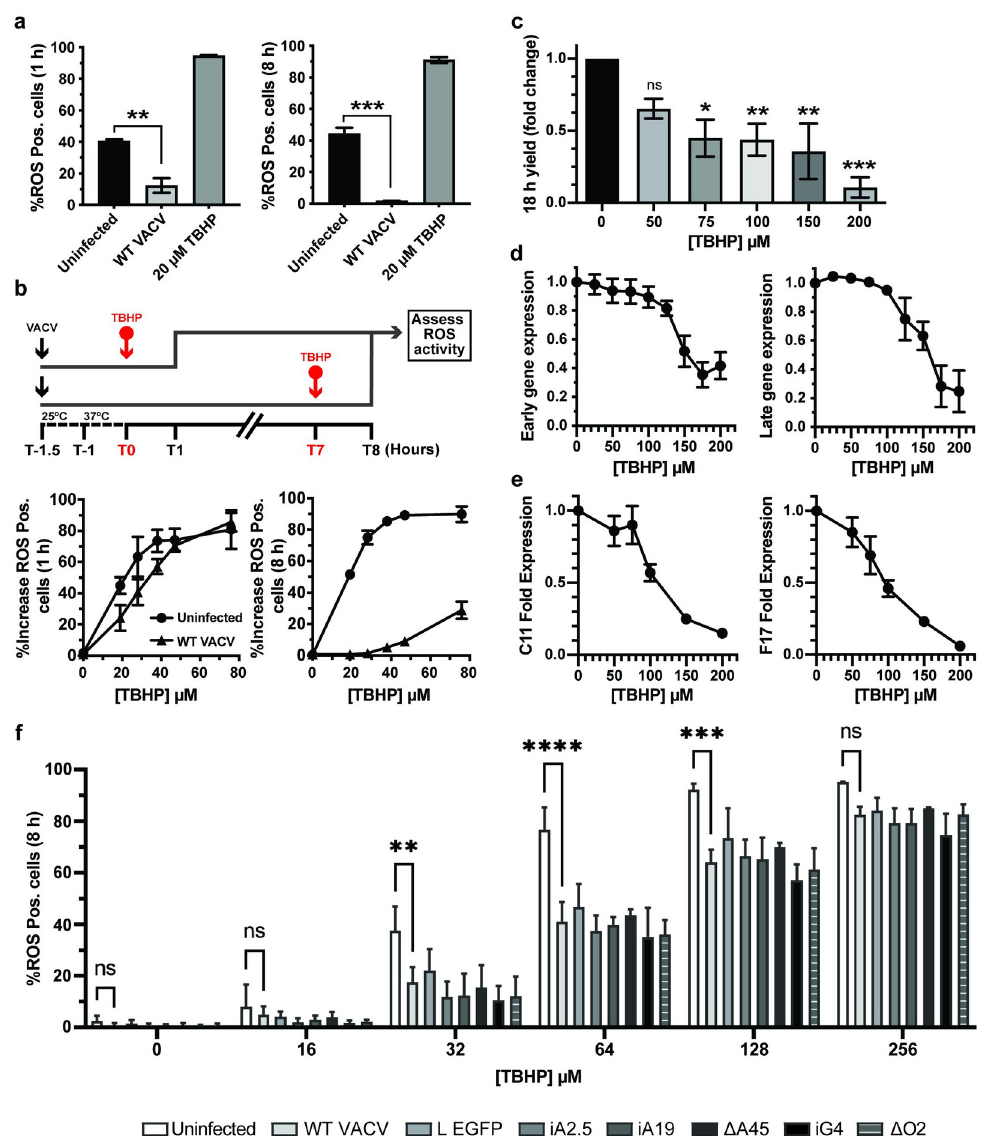
Fig 4. VACV supresses host cell oxidative responses to promote infection. (a) The percentage of ROS activated A549 cells measured at 1 and 8 h pi in cells left uninfected (black bar) or infected with WT VACV (Light grey bar). As a positive control, uninfected cells were treated with 20 μ M TBHP for the final hour of the experiment (dark grey bars). (b) Top: schematic of experiment to assess impact of VACV infection on ROS activation. VACV was bound to A549 cells for 30 min at RT prior to being shifted to 37˚C for 1 h. Cells were challenged with the indicated concentrations of ROS inducer TBHP for 1 h prior to quantification of ROS-positive cells at 1 h pi and 8 h pi. Bottom: The percentage of uninfected (circles) and infected (triangles) ROS positive cells at 1 h pi and 8 h pi challenged for the final hour with the indicated concentrations of TBHP (n = 3; ± SEM). (c) A549 cells were infected with WT WR VACV (MOI = 1) in a range of TBHP concentrations. At 18 h pi, the infectious virus yield was assessed by plaque assay (n = 3; mean ± SEM). (d) A549 cells infected with WR E-EGFP or L-EGFP were challenged with the indicated concentrations of TBHP for 8 h. Early and late viral gene expression was assayed by flow cytometry and the data plotted as the fold change from infected untreated cells (n = 3; mean ± SEM). (e) A549 cells infected with WT VACV were challenged with the indicated concentrations of TBHP for 8 h. Total RNA was extracted and early (C11R) and late (F17R) gene expression assessed by RT-qPCR. Data is displayed as fold expression normalised to GAPDH (n = 3 ± SEM). (f) Following the schematic in (b), the percentage of ROS activated A549 cells was measured using MitoSOX Red at 8 hpi in uninfected (white bar) or WT, WR L-EGFP, iA2.5, iA19, Δ A45, iG4, or Δ O2 infected cells and treated with indicated concentrations of TBHP for the final hour of the experiment (n = 3 ± SD). (a, c, f) � P < 0.05, �� P < 0.005, ��� P <